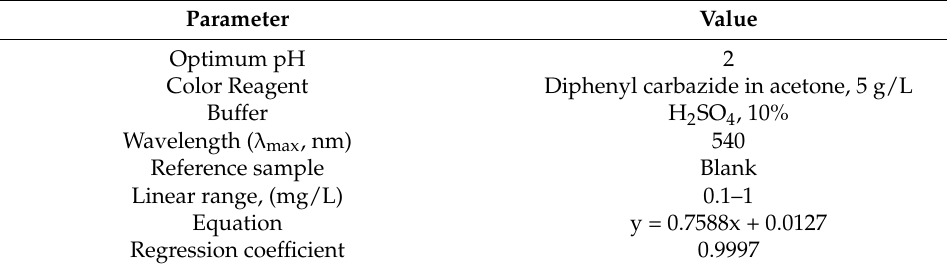
Table 2. Determination of Cr 6+ concentration in